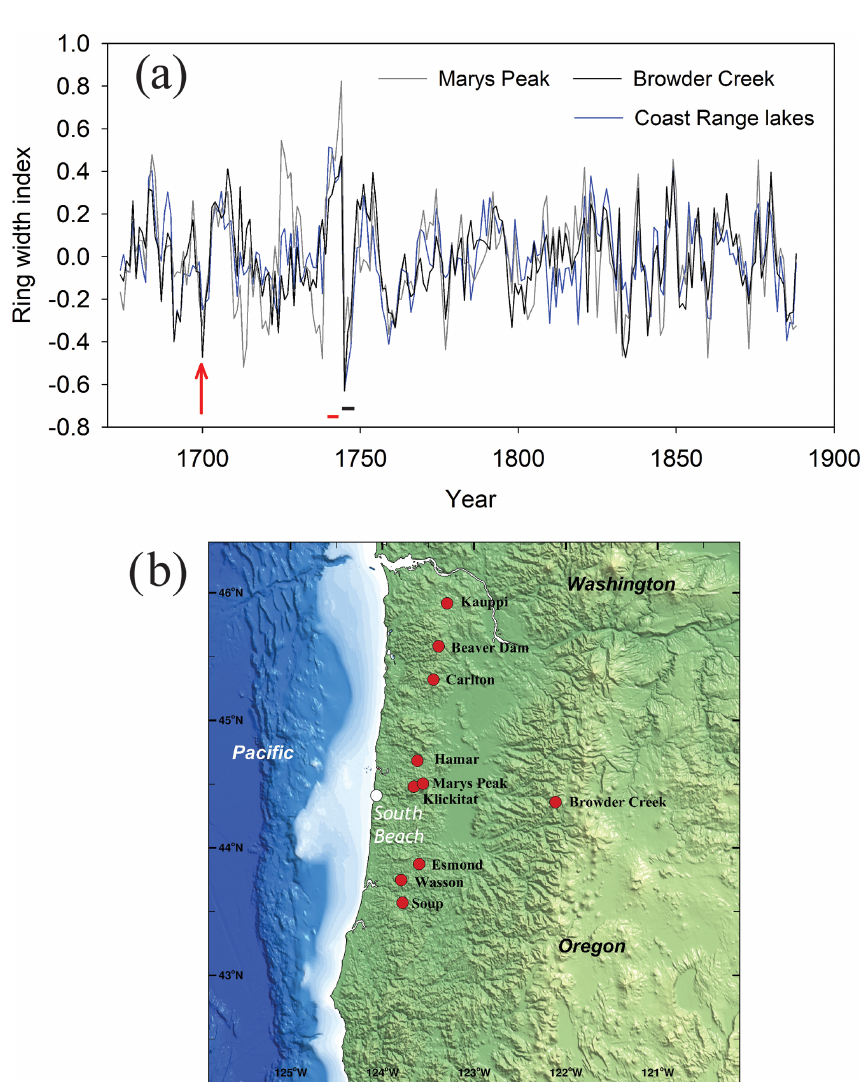
Figure 5. (a) Difference in growth chronologies between Mike Miller and reference sites at Marys Peak, Browder Creek, and Oregon Coast Range lake sites. The 1700CE chronology indicated by the red arrow, and the significant growth differences between coast and inland sites in 1739–1741 and 1745–1748 are highlighted by red and black lines, respectively. Panel (b) shows location map with Marys Peak and lake sites relative to South Beach. The number of cores available at each site during the 1700 time period are South Beach (14), Marys Peak (28), Oregon Coast Range lakes (31), and Browder Creek (30). The Oregon Coast Range lakes include Beaver Dam Lake, Carlton Lake, Esmond Lake, Hamar Lake, Kauppi Lake, Klickitat Lake, Soup Lake, and Wasson Lake. Map created using digital elevation data points complied by the National Center for Environmental Information (http://ncei.noaa.gov, last access: September